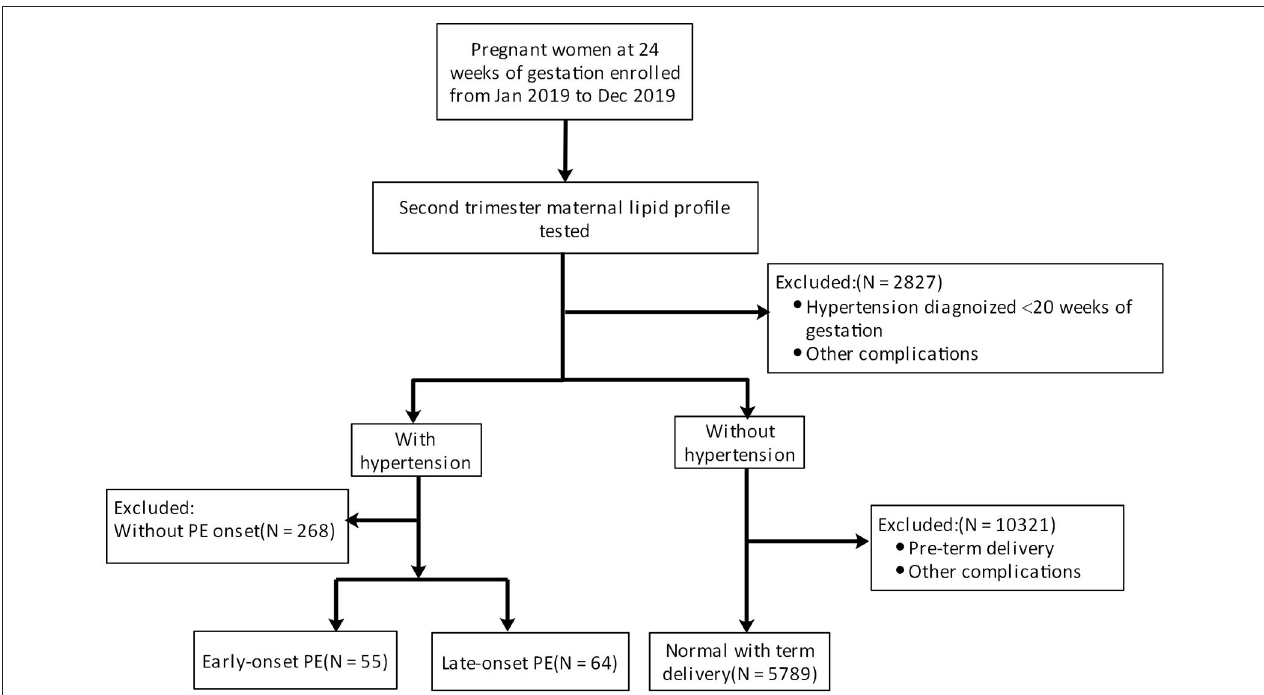
FIGURE 1 | Pregnant women were first enrolled (excluding those with hypertension or other comorbidities) at 24 weeks of gestation. Then, the lipid profile was evaluated. Pregnant women were classified into a healthy group, an early-onset PE group, and a late-onset PE group by observing PE development. 6 to 12 h. Therapy details and final clinical outcomes